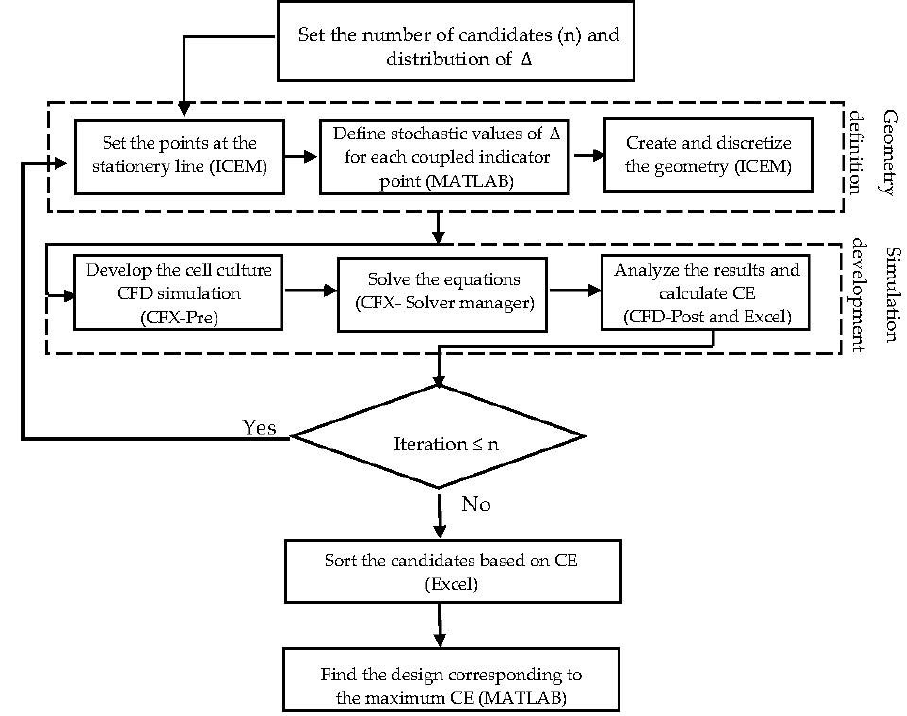
Figure 5. A schematic view of the stochastic semi-optimization routine.